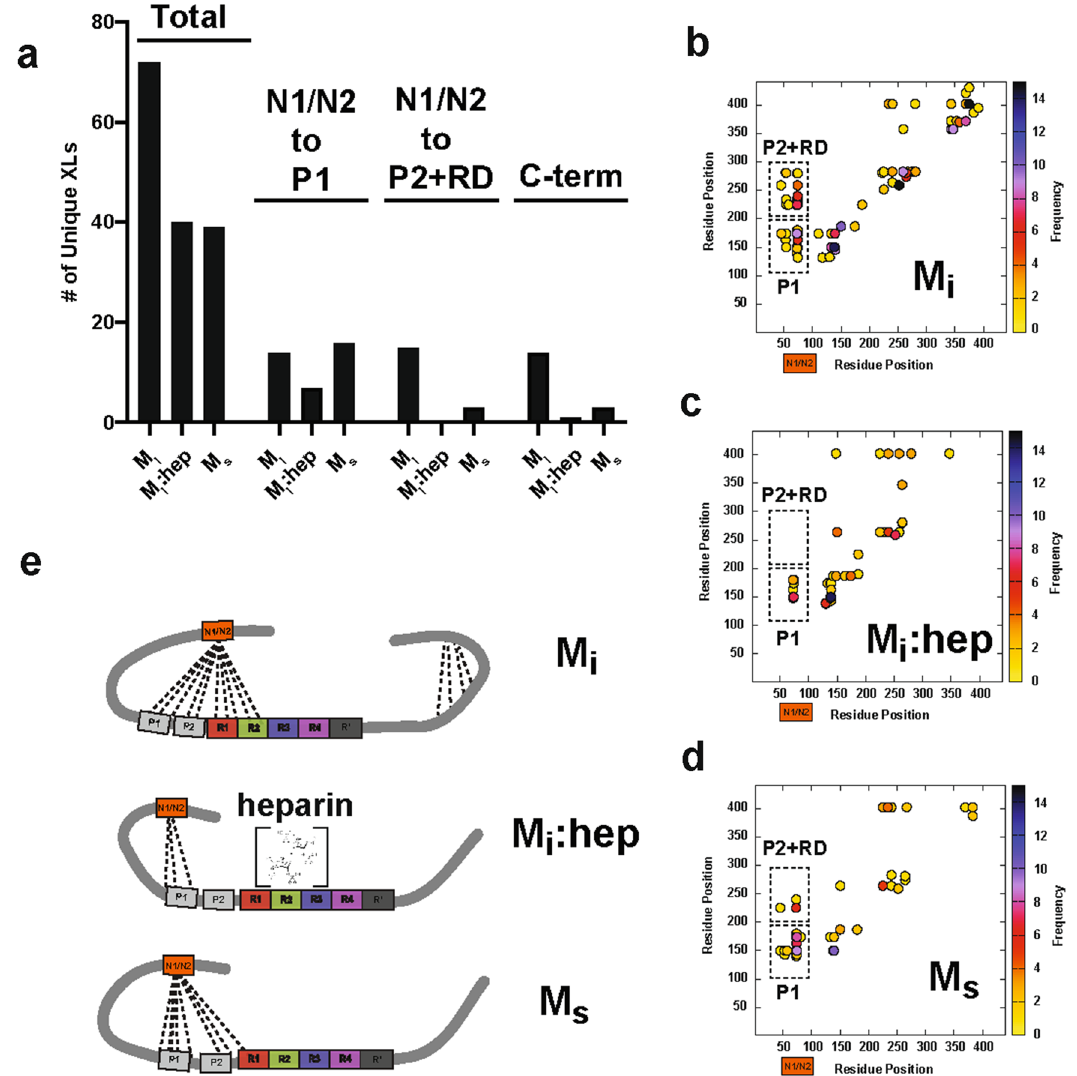
Figure 3. Topological changes in tau during seed formation. ( a ) Summary of unique crosslinks identified in M i , M i :heparin and M s . Experiments were performed as five replicates and data is shown as unique crosslinks observed across replicates. Total crosslinks are shown on the left, specific crosslinks observed from the acidic N-terminal N1/N2 domains (residues 45–101) to the P1 domain (residues 151–198, middle) and P2/RD domains (residues 199–368, right). Scatter plots of crosslinks identified in ( b ) M i , ( c ) M i :heparin and ( d ) M s samples. Colors indicate the frequency of contacts. Dashed boxes highlight N-terminal N1/N2 contacts to P1 and P2/RD. ( e ) Model of tau conformational changes along the pathway of seed formation show changes in contacts from acidic N-terminal N1/N2 (orange) to P1/P2 (grey) and RD (red, green, blue and